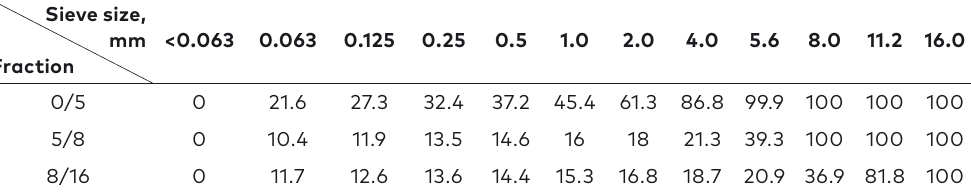
Table 7. Granulometric composition of RAP